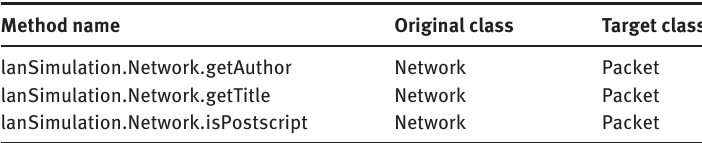
Table 2. Methods Should Be Moved for LAN-Simulation.